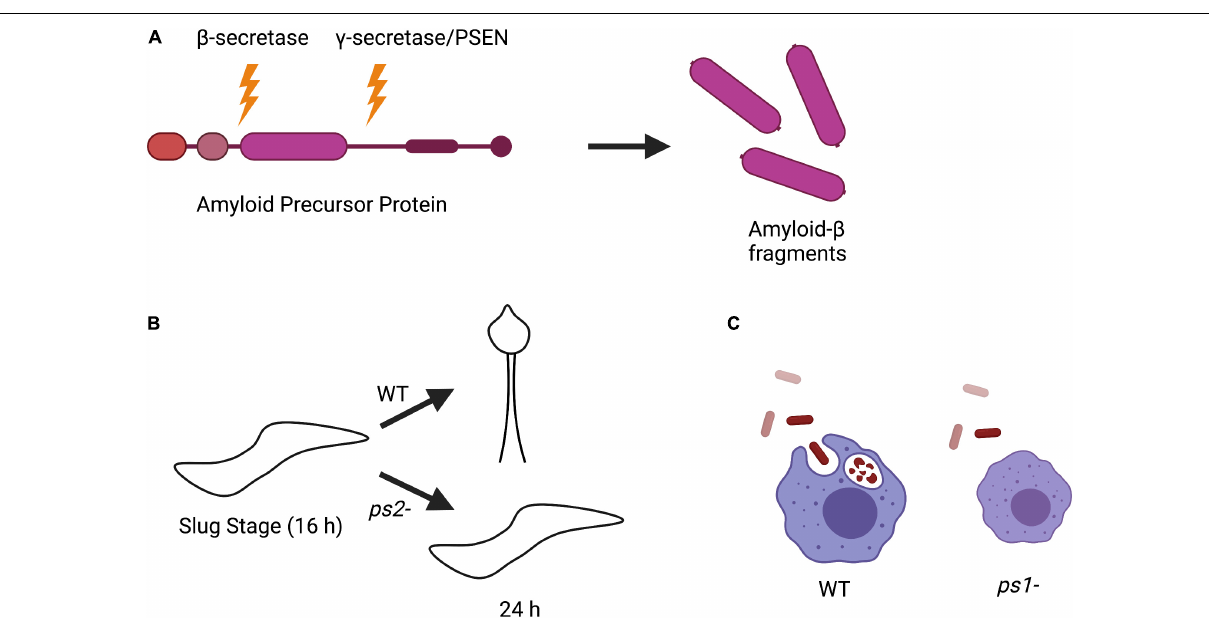
cells that PSENs are present in lysosomal membranes ( Figure 3C